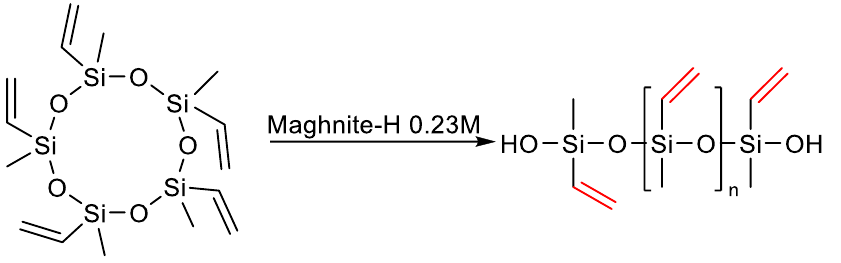
Figure 25. Polymerization of V 5 D 5 by Maghnite-H + .